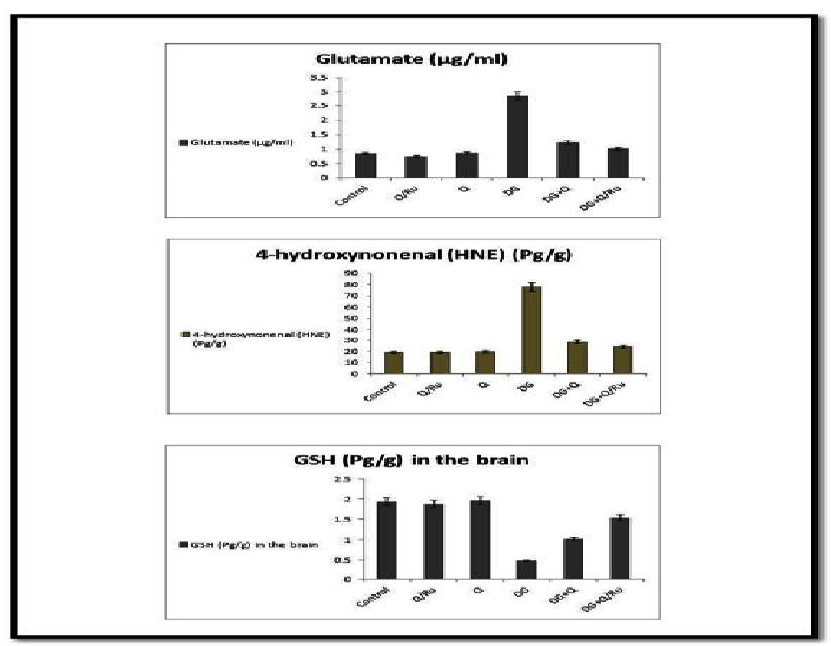
Figure 10. Effect of DG, Q and Ru III /Q alone or either combined on glutamate, 4-hydroxynonenal and glutathione (GSH) levels.